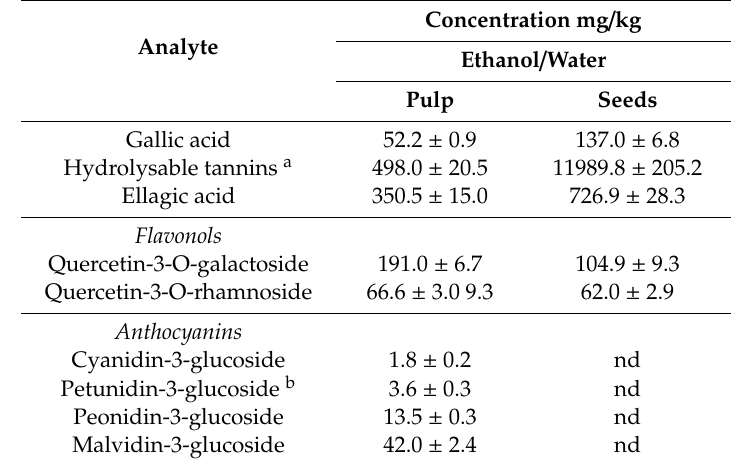
Table 1. Phenolic compounds quantified in myrtle liqueur byproducts. Average content (mg / kgDW) with their standard deviations, n = 3 replicates.